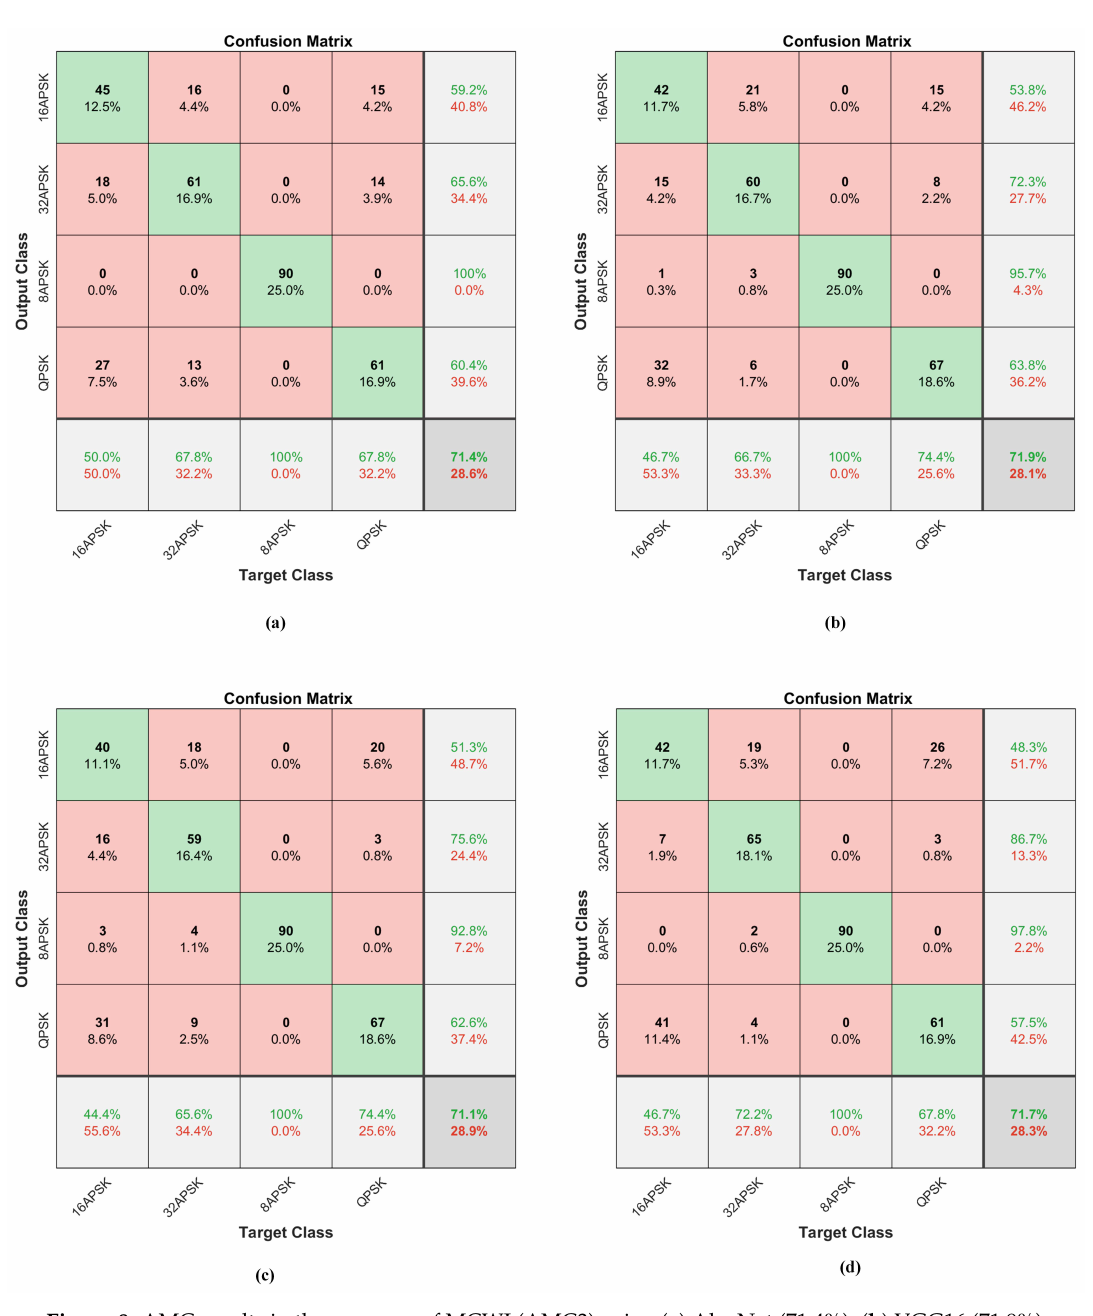
Figure 8. AMC results in the presence of MCWI (AMC3) using ( a ) AlexNet (71.4%), ( b ) VGG16 (71.9%), ( c ) GoogleNet (71.10 %), and ( d ) ResNet18 (71.7%). Figure 9 demonstrates the AMC results in the presence of CI. As is clear, the highest precision is 81.90%, using